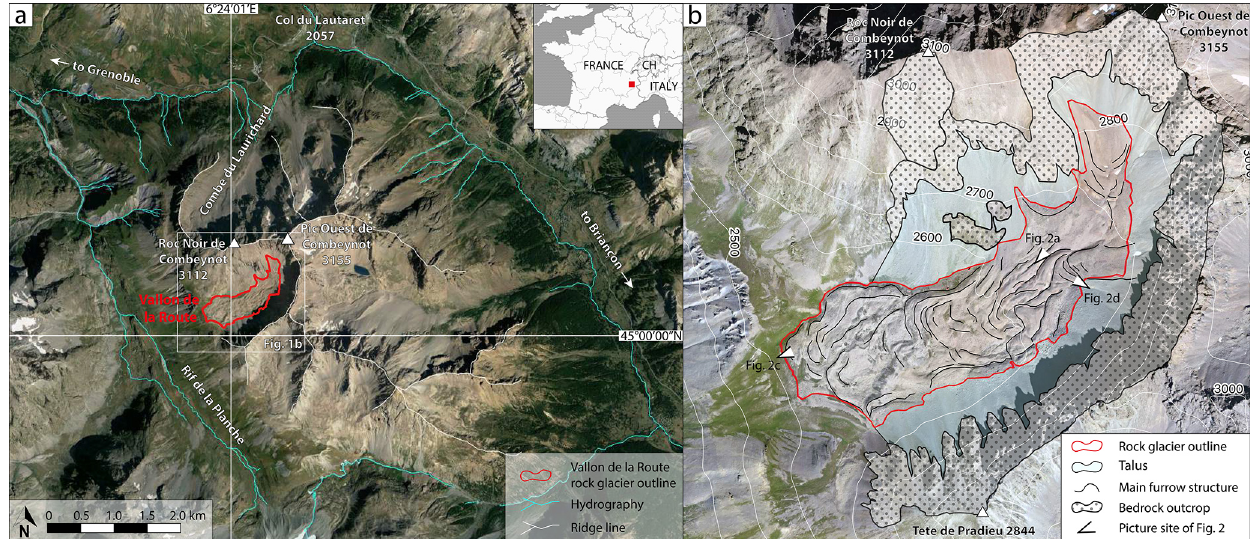
Figure 1. (a) Regional map of the Combeynot Massif showing the Vallon de la Route rock glacier and surrounding topography (satellite image from © Google Earth 2020). Outline of the rock glacier (red), hydrography (cyan), and ridge line (white) from Bodin (2007). The inset in (a) shows location of the Vallon de la Route rock glacier within western Europe. (b) Map of the Vallon de la Route rock glacier, with the outline of the rock glacier, the main furrow structures, the outline of the bedrock outcrops (from Bodin, 2007), and the location and orientation of pictures presented in Fig. 2. The satellite image from Bing Aerial ©